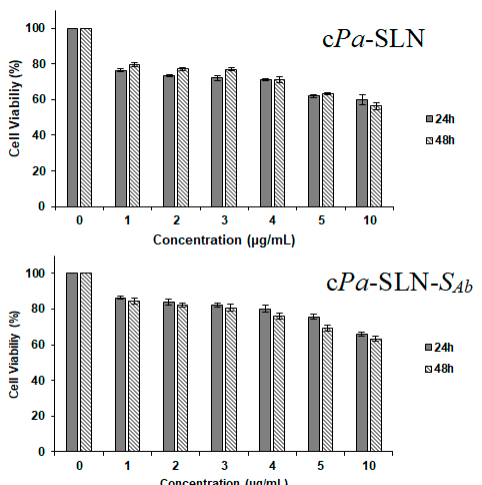
Figure 5. Variation on the mean particle size (z-Ave, upper panel) and zeta potential (ZP, lower panel) of c Pa -SLN- S Ab complexes obtained from the binding of the antibody with different c Pa -SLN—Streptavidin binding ratios. Results are given as mean from three measurements of three independent experiments.